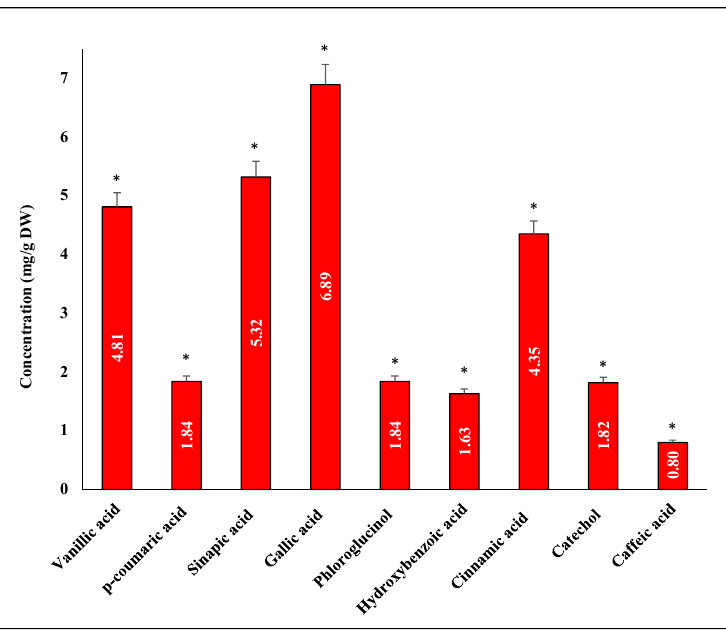
Figure 8. HPLC profile of phenolic compounds in methanol extract of U. lactuca (highly significant = * p < 0.05, n = 3).